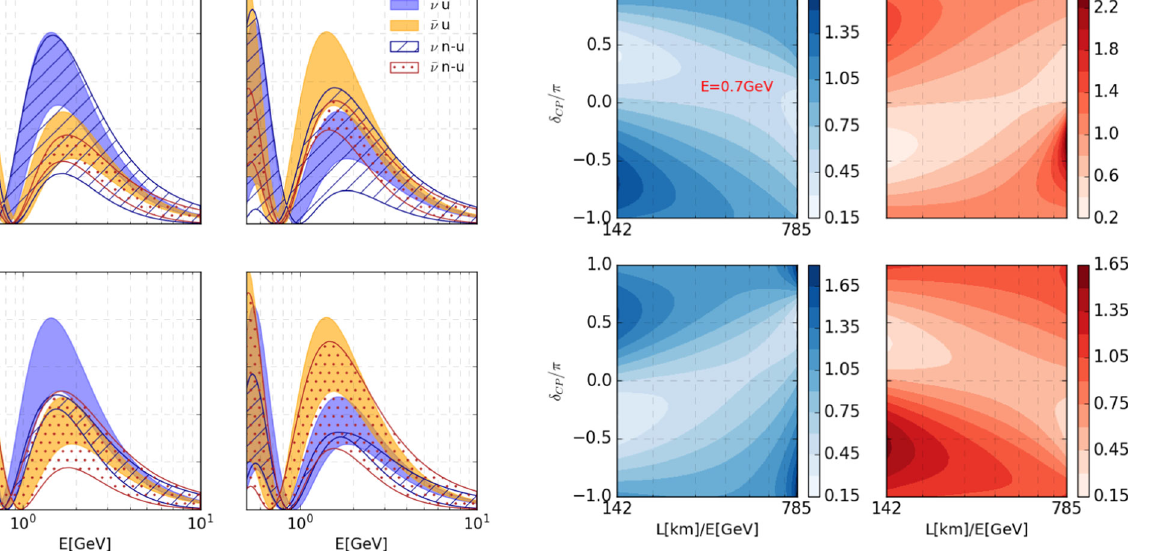
discussion that data from the NO ν A and T2K experiments may not constrain the non-unitarity significantly.